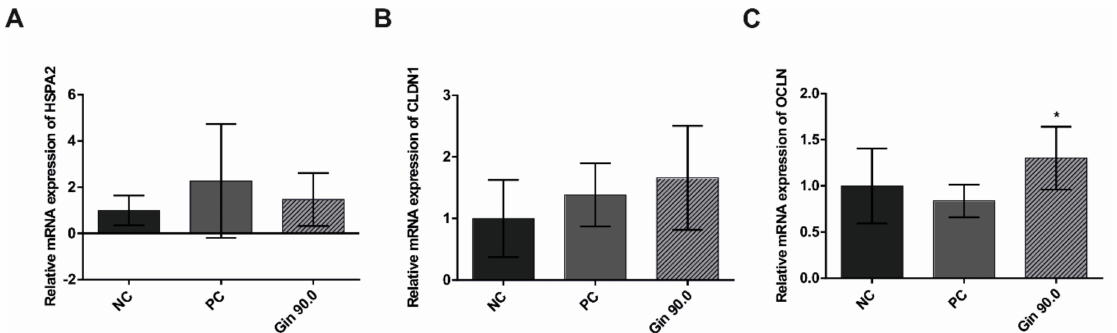
Figure 6. Jejunal mRNA expression of a heat shock protein gene and tight junction protein genes in growing broilers under heat stress conditions (day 22–42) fed diets containing no additive (negative control), 1000 mg / kg ActiBeet ® , as natural betaine source (positive control), or 90 mg / kg ginsenosides (Gin 90.0). The expression levels of HSPA2 ( A ), CLDN1 ( B ) and OCLN ( C ) are indicated as fold-changes normalized to the average levels under the cyclic heat shock control temperature conditions of 34 ◦ C. The error bars are based on the standard deviation ( n = 6). * p < 0.05 indicates significant di ff erences from the negative control under the 34 ◦ C heat stress